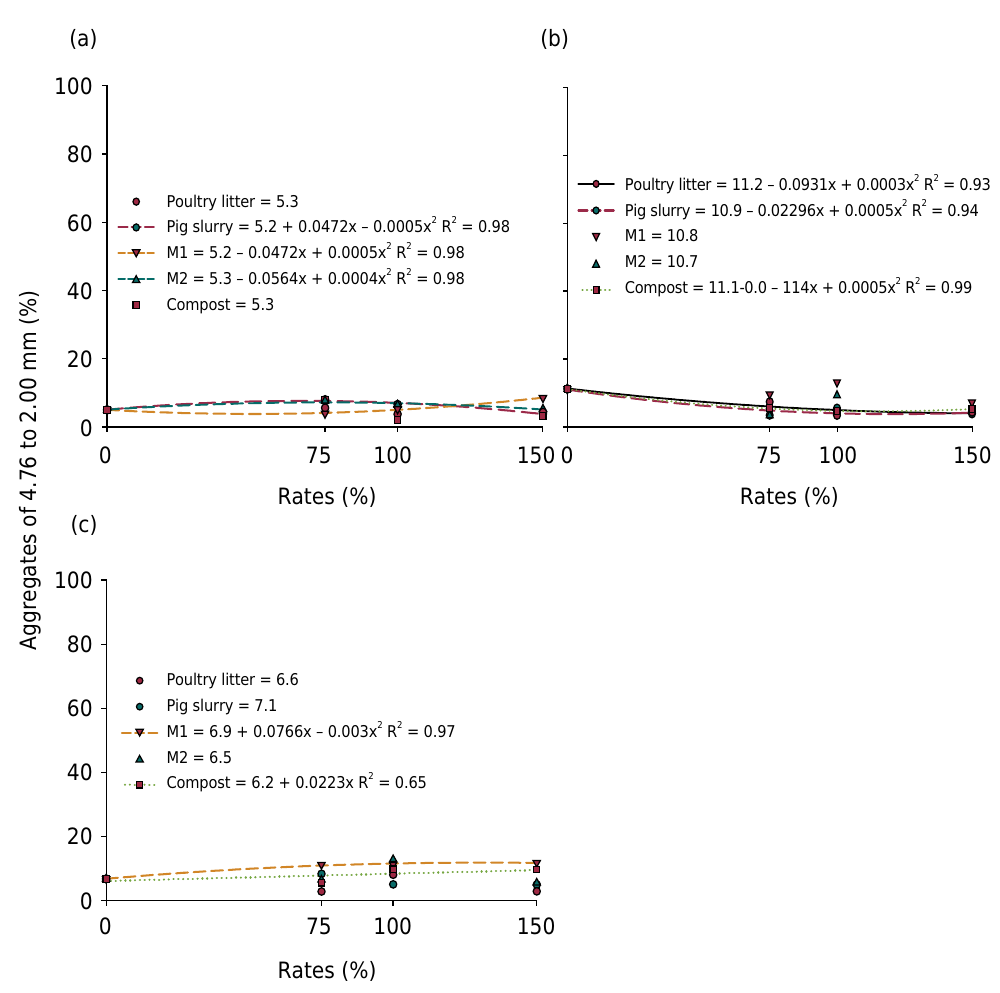
Figure 4. Percentage of aggregates of the class (C2 = 4.76 to 2.00 mm) in the Rhodic Kandiudox, in the layers after seven years of application of different types and rates (%) of organic and mineral fertilizers. (a) 0.00-0.05 m soil layer; (b) 0.05-0.10 m soil layer; and (c) 0.10-0.20 m soil layer. M1: mineral fertilizer 1, equivalent to pig slurry; M2: mineral fertilizer 2, equivalent to poultry